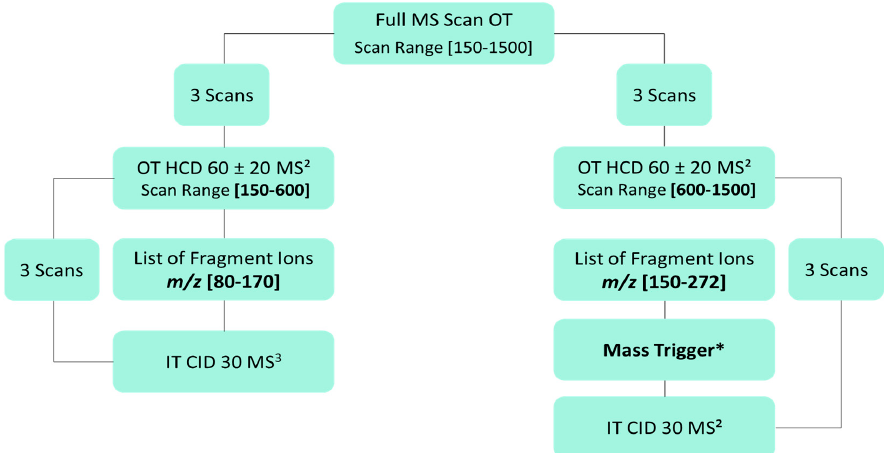
Figure 8. Top3 ddMS 2 /MS 3 decision tree, driven for the nontargeted analysis of flavonoids. Two fragment ion lists were defined based on the targeted fragmentation of fifteen infused